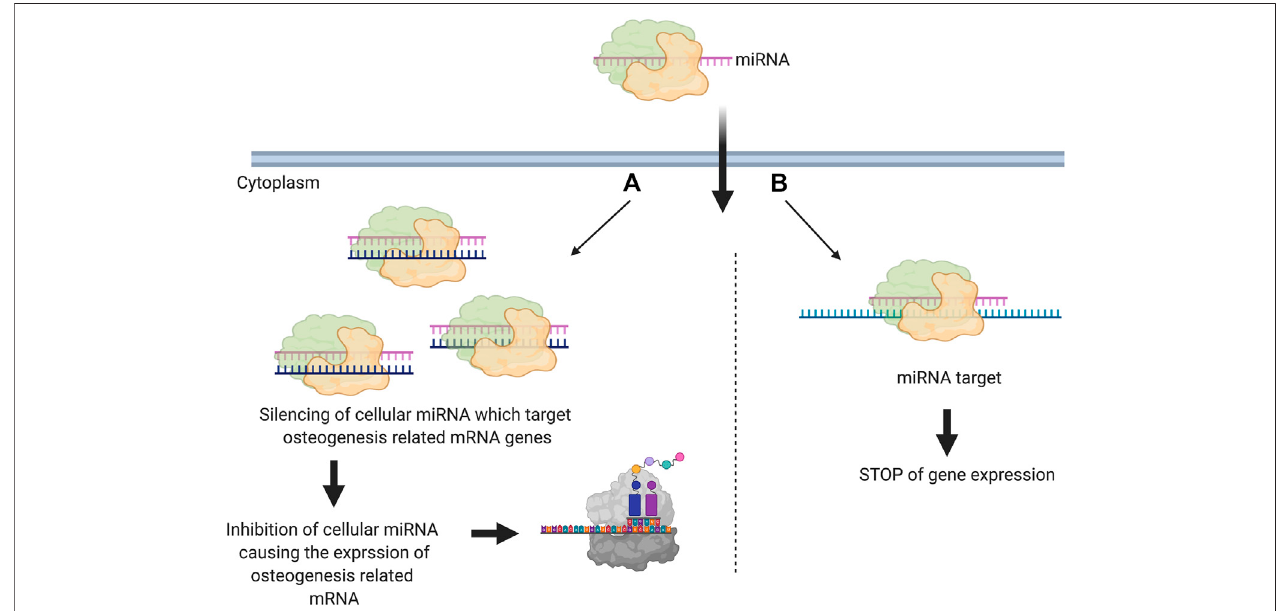
FIGURE 2 | Schematic illustration showingthe two main used methods for miRNA mediated gene silencing in scaffold-based bone regeneration. miRNA is introduced into cells and works on silencing (A) cellular miRNA that can target osteogenesis related genes (anti-miRNA) (B) osteogenesis related genes (Created with BioRender.com).